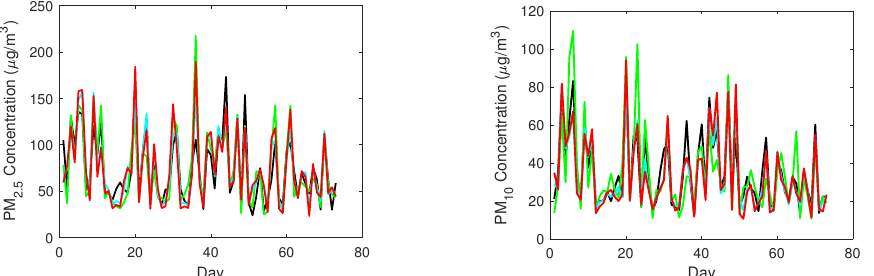
Figure 9. The observed concentrations and the predicted concentrations of DTR, FFANN-BP and RFR for PM 2.5 and PM 10 at Ma Lian Kou, where the red line and the black, green and lightcyan lines represent the observations, and the predictions of DTR, FFANN-BP and RFR, respectively.